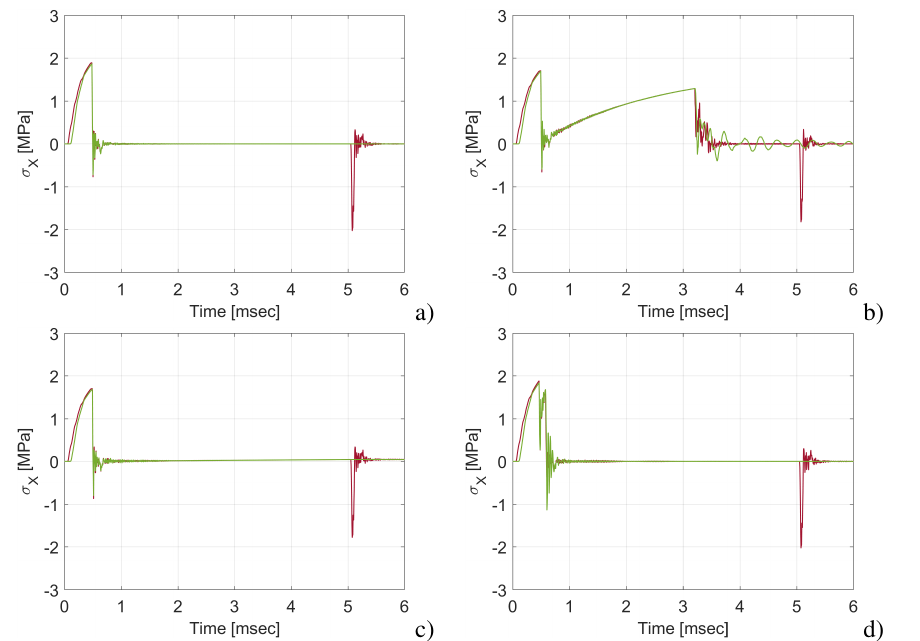
Figure 3. Input (red) and output (green) pulses for: a) standard concrete; b) LDPE; c) silicone rubber; d) UF